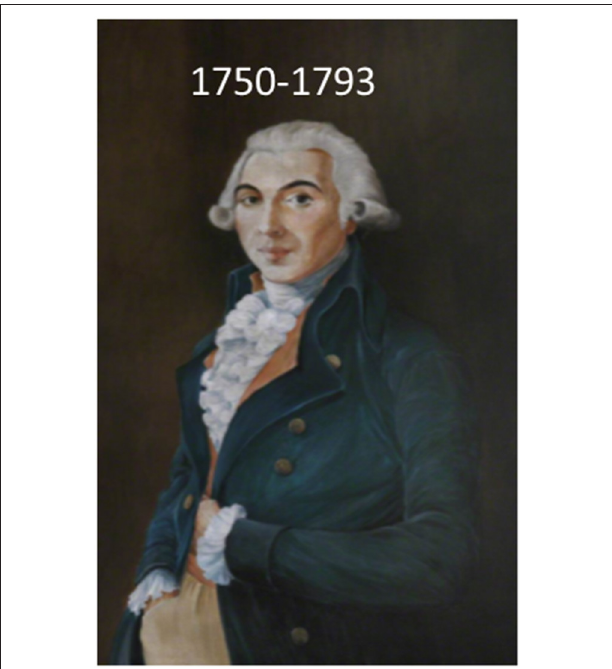
FIGURE 3 | Benoit Vial de St. Bel (1750–1793). Charles Vial de Saint-Bel was born at Lyon (France) in 1753. He studied at the Veterinary School of Lyon, and then was appointed Assistant Professor at Alfort, where he quickly encountered hostility from Bourgelat. On his departure, Bourgelat wrote against Vial’s name “Renvoyé comme sujet cabaleur, intrigant et detestable” (Returned as a boastful, intriguing, and detestable subject) and Bourgelat wanted to imprison him in the Bastille. In 1788, he prudently left for England where he married an “English lady of great accomplishments. “He then returned to France before being exiled in 1789 in London at the beginning of the French revolution. There, he met Granville Penn (grandson of William Penn of Pennsylvania) who helped him to express in English his plan to establish a first veterinary school in Great Britain.” On February 18, 1791 “The Veterinary College of London was created; SAINT-BEL was its “Professor.” On August 22, 1793, Charles VIAL de SAINT-BEL, at the age of 40, died of Snot (glanders) (26,